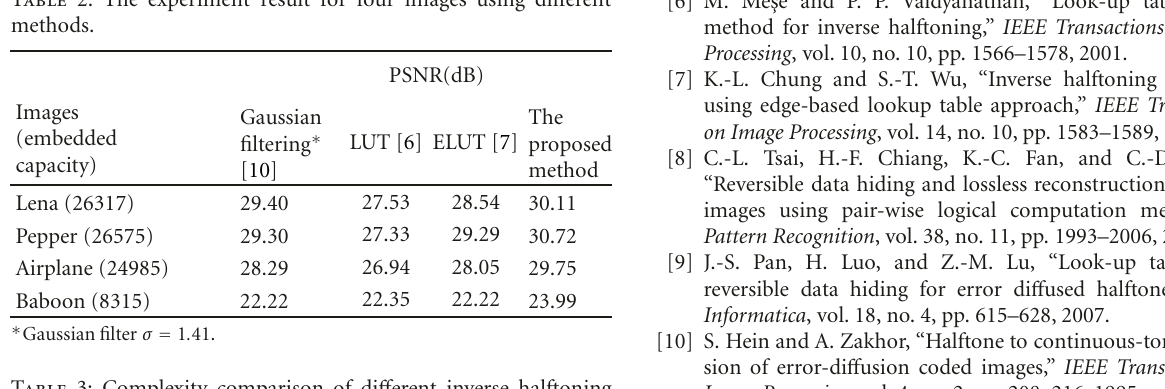
Table 3: Complexity comparison of di ff erent inverse halftoning